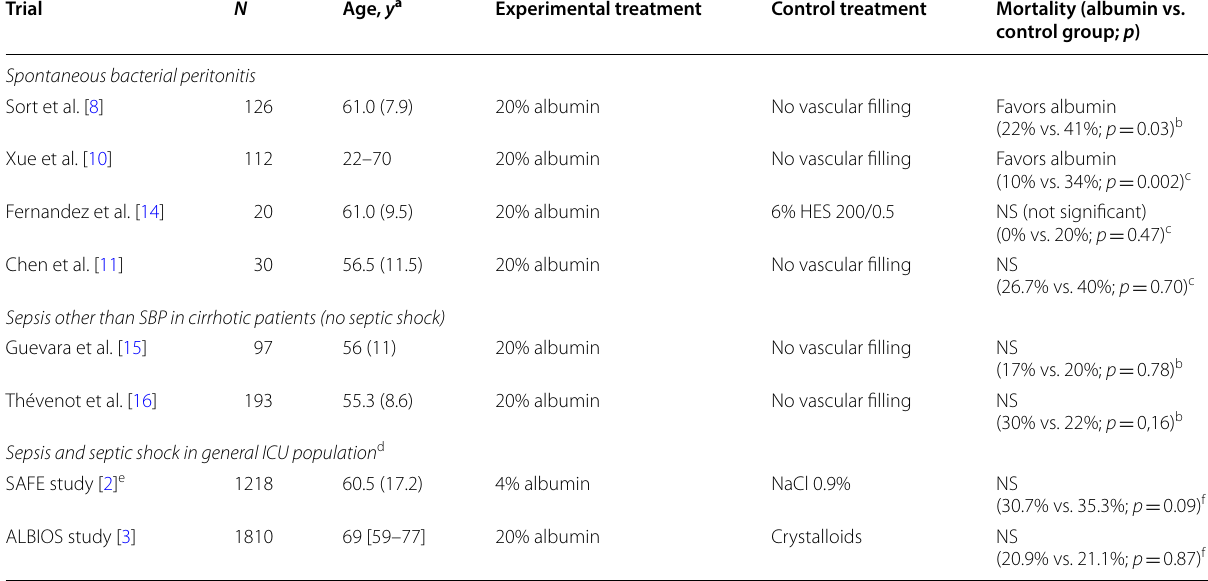
Table 1 Characteristics, details of interventions used and outcomes measured in randomized trials studying albumin treatment during spontaneous bacterial peritonitis, sepsis other than SBP in cirrhotic patients and general ICU population with